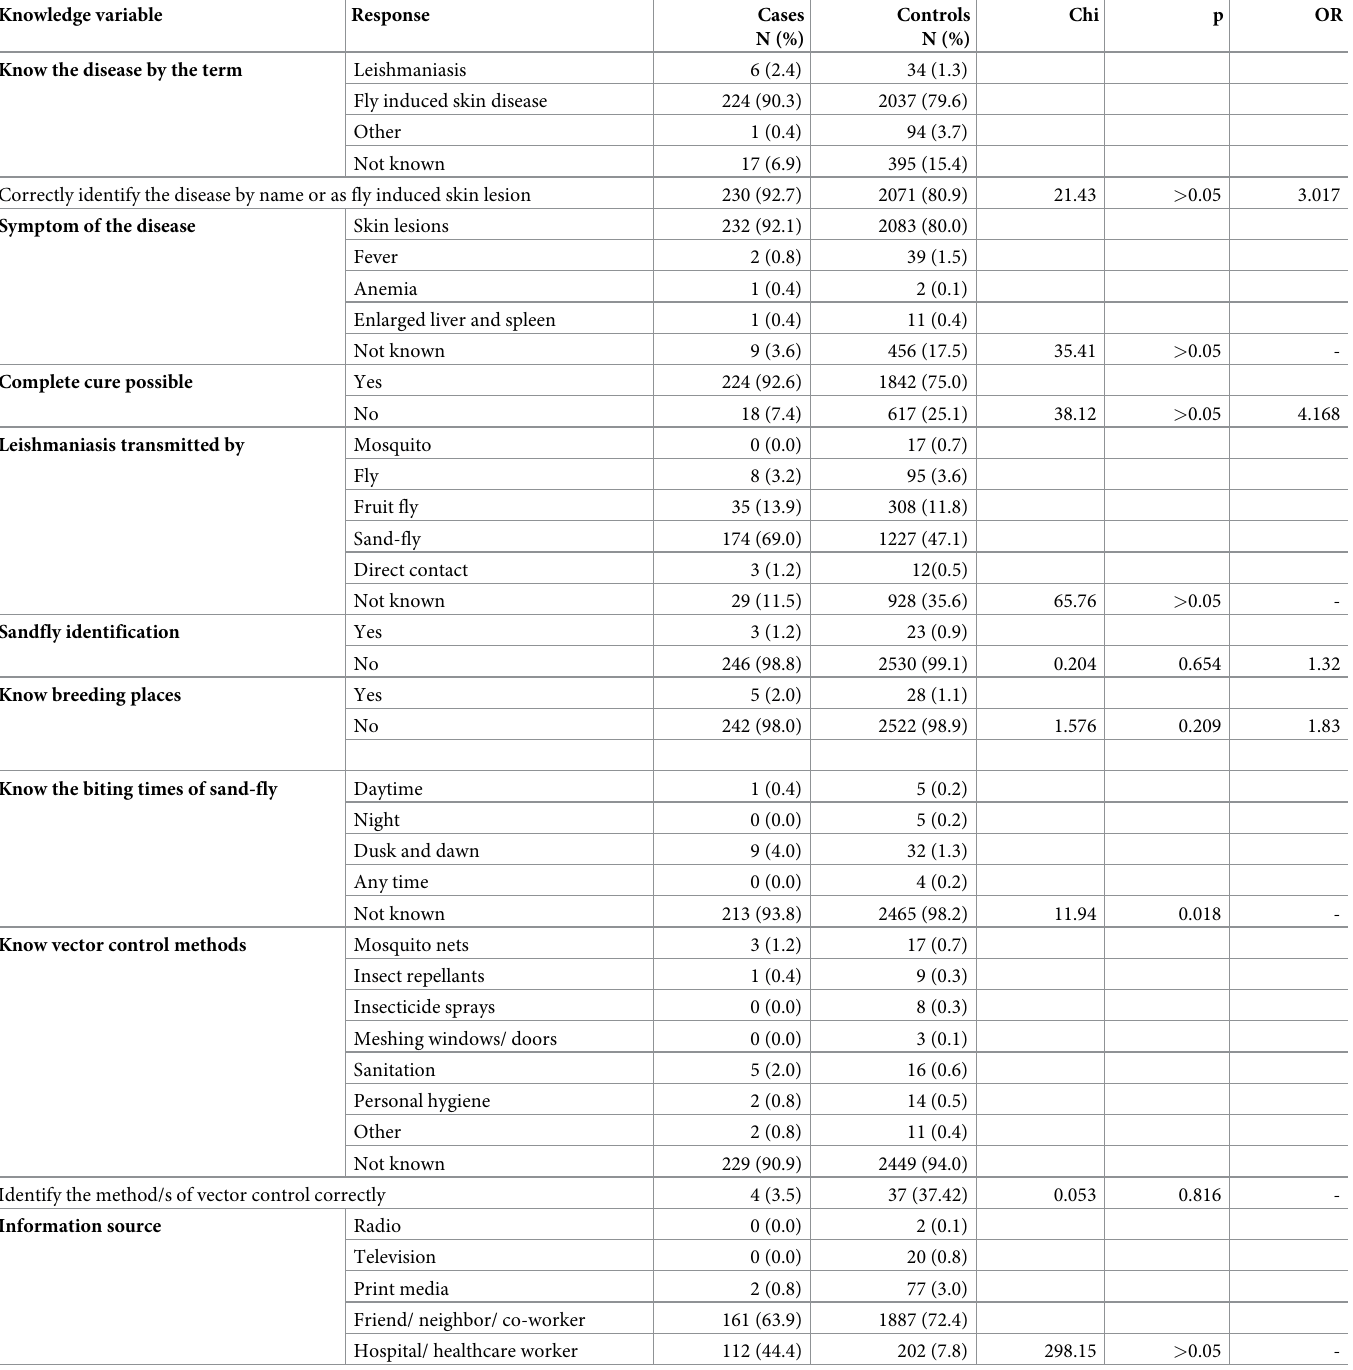
Table 2. Comparison of knowledge attributes between the cases and